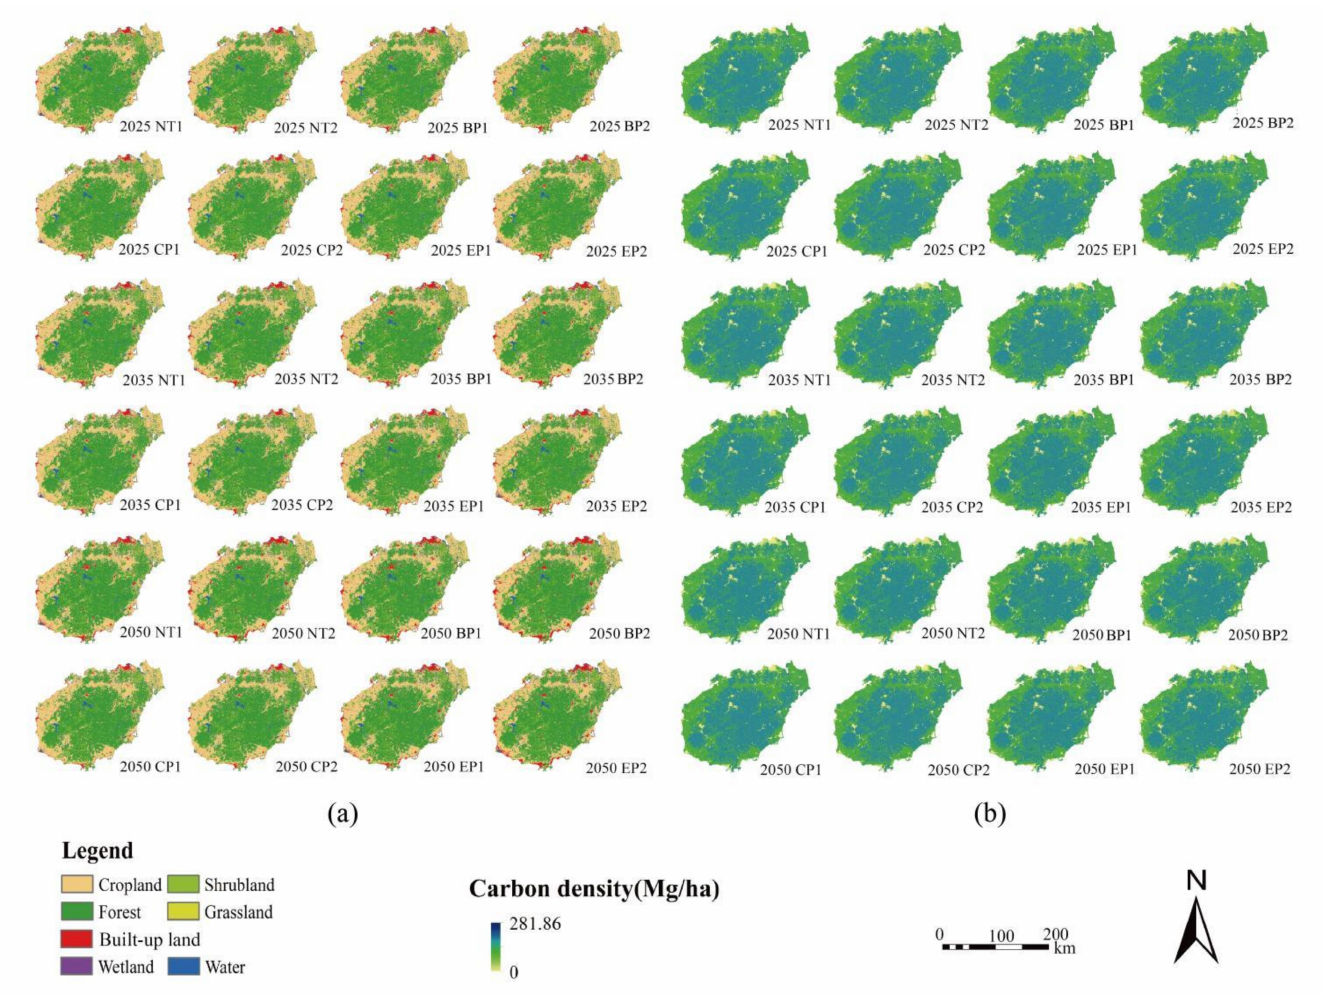
Figure 11. ( a ) Distribution of LULC of Hainan Island under different future development scenarios; ( b ) distribution of carbon storage of Hainan Island under different future development scenarios. 1 denotes Pattern 1 and 2 denotes Pattern